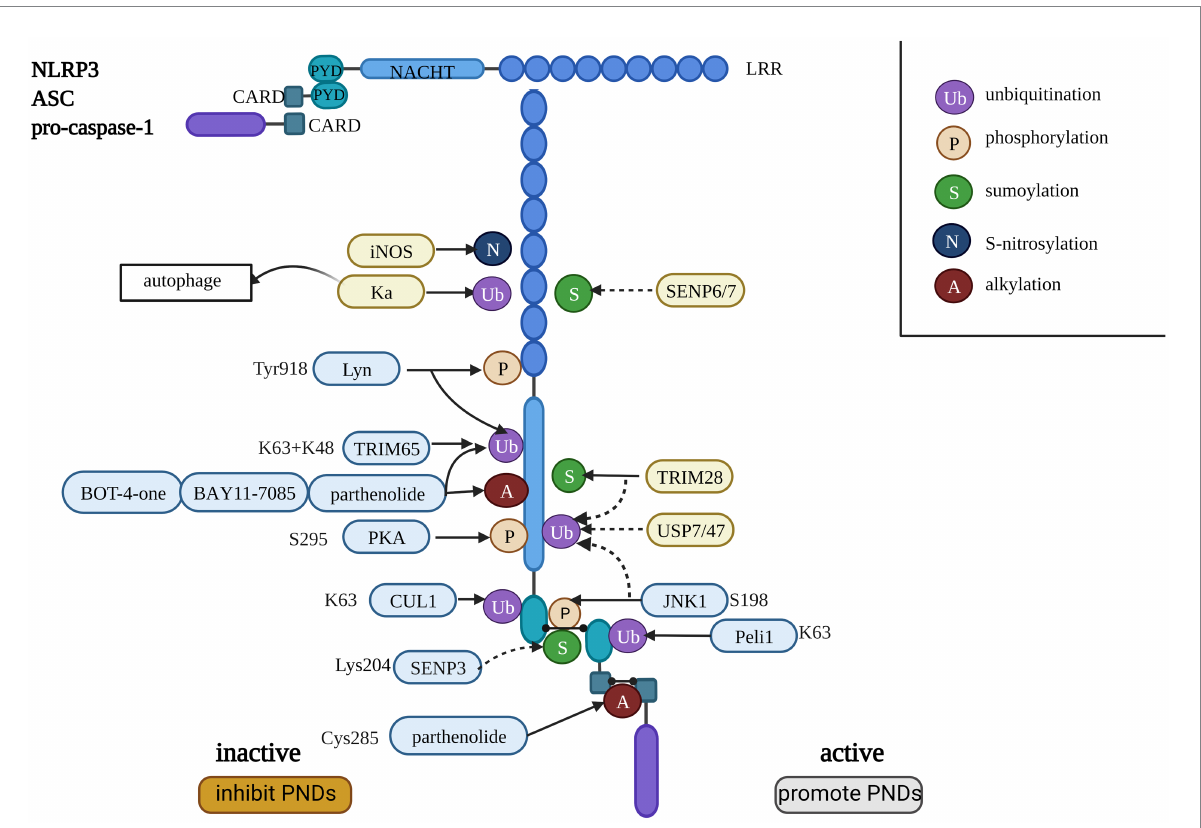
FIGURE 2 The consistency of the NLRP3 inflammasome and the regulation of PTMs on the NLRP3 inflammasome. The dotted line indicates the removal of small molecular modifications, and the solid line indicates the promotion of PTMs. The blue background indicates an explicit interaction site with NLRP3, and the yellow background indicates that the site is not clear. The molecules listed on the left side inactivate the NLRP3 inflammasome, and the factors on the right side activate the NLRP3